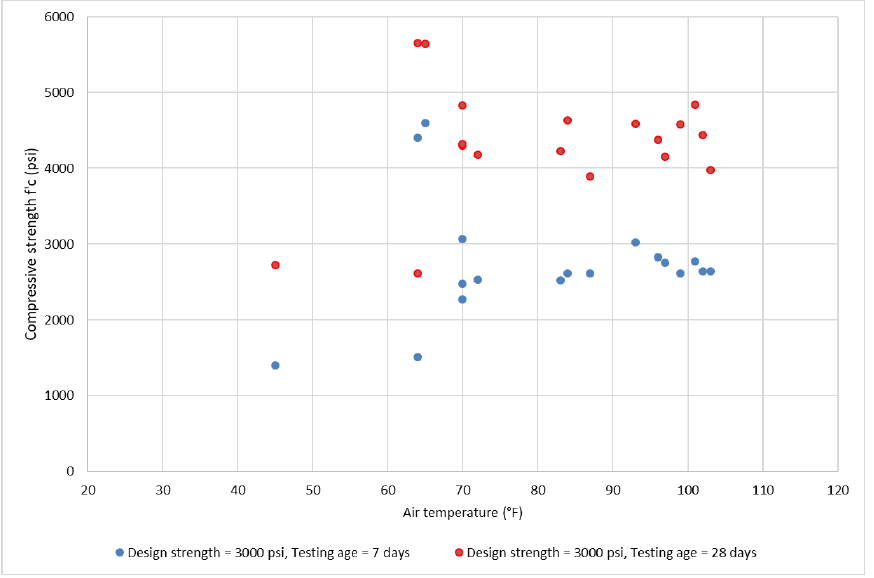
Figure 1. Relation between compressive strength and air temperature for a design strength of 3000 psi.